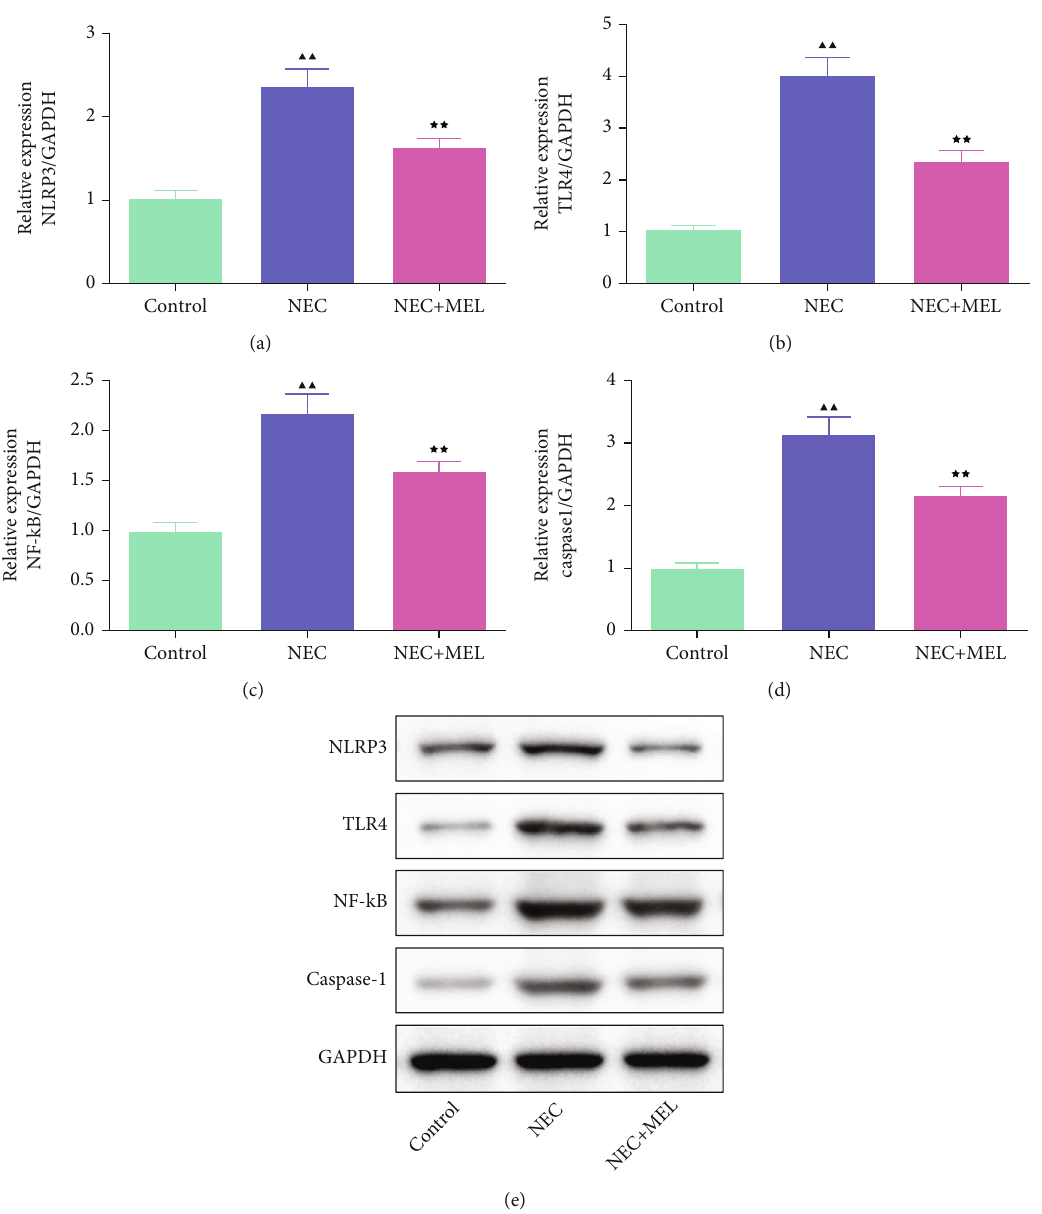
Figure 6: MEL attenuated the protein levels of NLRP3, TLR4, NF- κ B, and caspase-1 of the terminal ileum tissues in NEC mice. (a – d) The e ff ect of MEL on the protein levels of NLRP3, TLR4, NF- κ B, and caspase-1 of the terminal ileum tissues in NEC mice was estimated by Western blot. ▲▲ P < 0 : 01 vs. control; ★★ P < 0 : 01 vs.